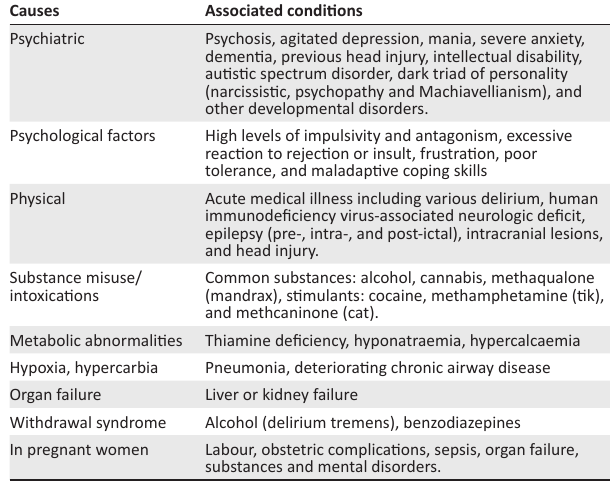
TABLE 1: Medical conditions associated with aggressive and violent behaviours.